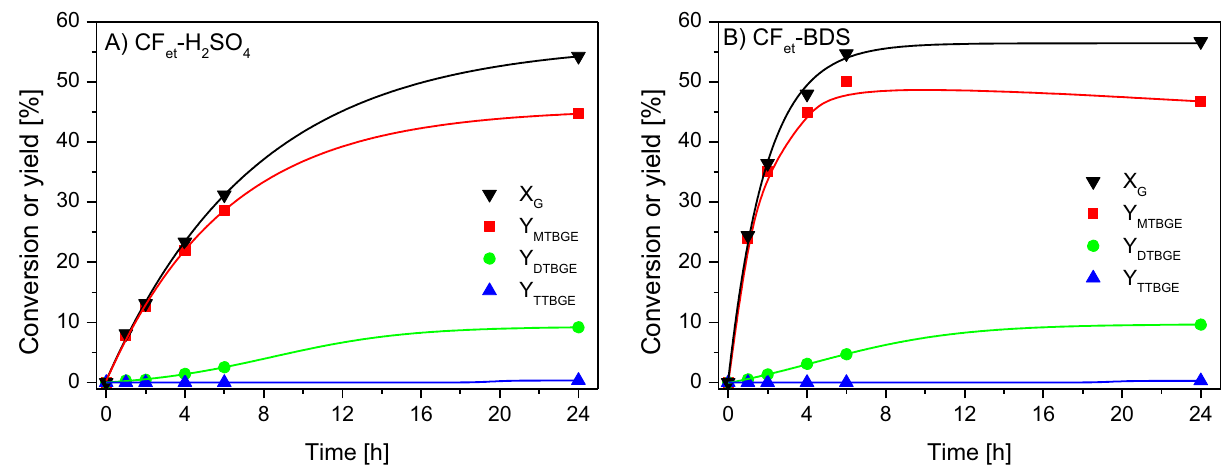
Figure 8. Conversions of glycerol (X G ) and yields (Y) of individual products obtained in the glycerol etherification performed with tert-butyl alcohol over ( A ) CF et -H 2 SO 4 and ( B ) CF et